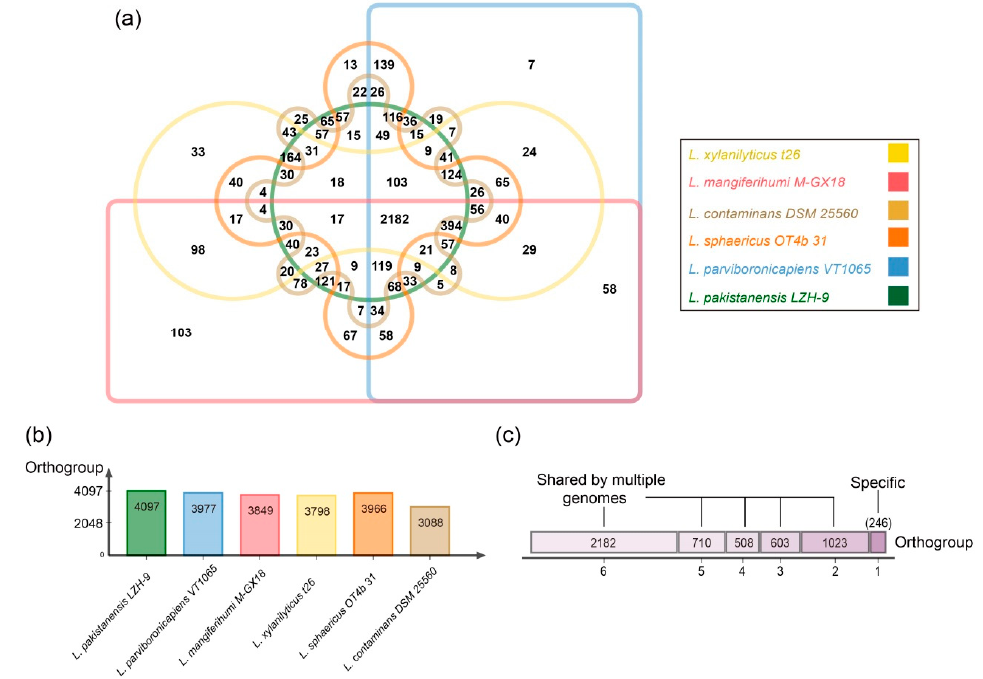
Figure 5. ( a ) Venn diagram showing the numbers of orthogroup including the core genome (shared by six representative strains of Lysinibacillus ), the accessory genome (shared by some but not at all of these strains) and strain-specific gene families in individual genomes; enriched Gene ontology (GO) terms ( p < 0.05) in respective orthogroups are shown in the tables. ( b ) Bar chart showing the total numbers of orthogroup identified in each genome of six representative strains of Lysinibacillus . ( c ) The total numbers of orthogroups of strain-specific gene families (=1) or the accessory genome (shared by two, three, four, five, six strains) and core genome of six representative strains of Lysinibacillus .